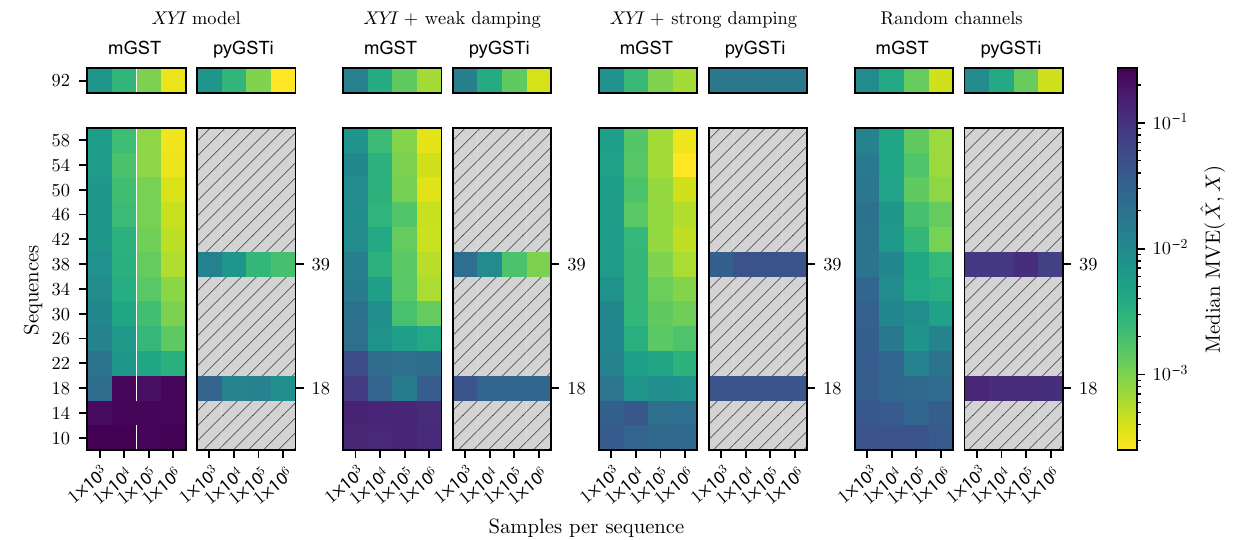
FIG. 1. MVE comparison between mGST (with loglikelihood cost function and r K = 4) and pyGSTi , showing the dependence on the number of sequences, the number of samples per sequence, and the gate set on a single qubit. The number of sequences used by mGST in the range 10–58 are drawn uniformly at random, while the sequences for pyGSTi need to follow the pyGSTi fiducial design and are limited to the fixed sequence counts (18 and 39). We choose independently drawn random fiducials for each instance. The 92 sequences used by both mGST and pyGSTi are taken from the standard pyGSTi sequence design for the XYI model. All sequences are of length (cid:2) = 7. The MVE depicted in each square is the median result for ten instances, each with random statistical measurement noise and a random sequence drawn from the uniform distribution. In the random channel scenario, a new random channel is used for each instance. The XYI model is a simple unitary model used in the GST literature and the weak damping model consists of amplitude damping noise on each gate with (cid:7) = 0.94, while the strong damping model uses (cid:7) = − 0.6. A complete description of the models used can be found in the main text. Each model has additional depolarizing noise of strength p = 0.01 on the initial